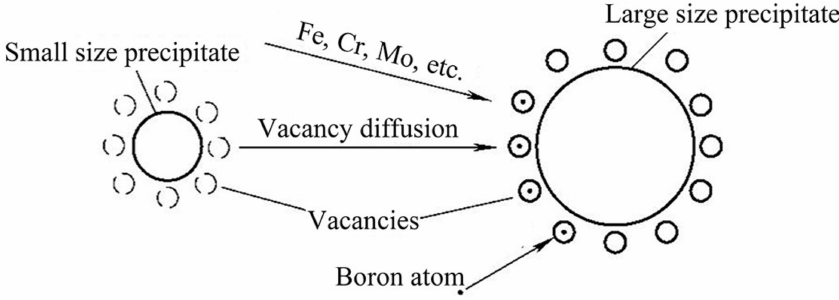
Figure 10. Schematic diagram for boron blocking precipitate coarsening